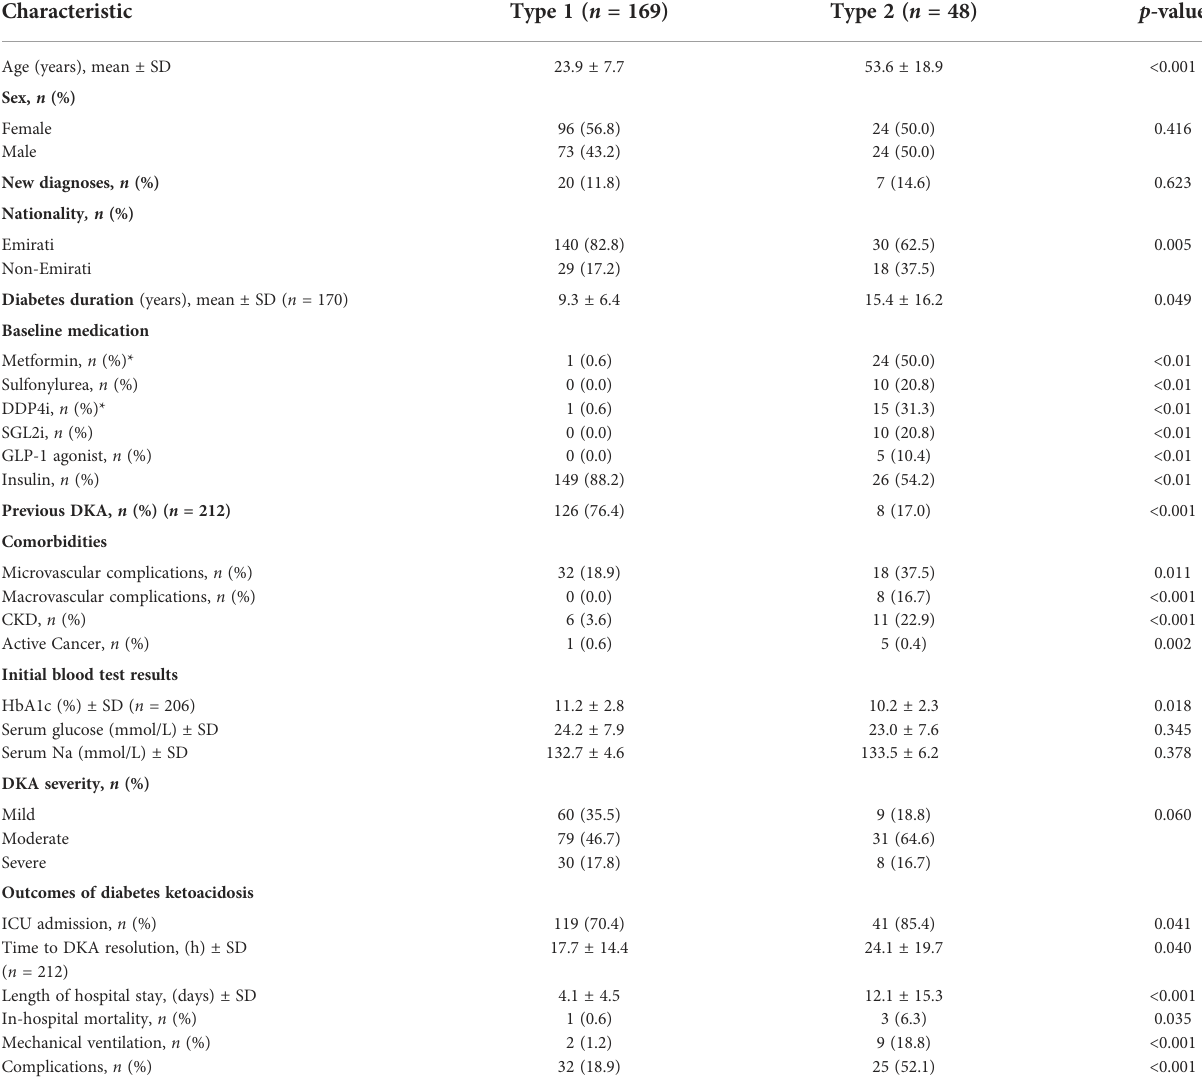
TABLE 4 Clinical characteristics of patients according to diabetes type ( n = 217).